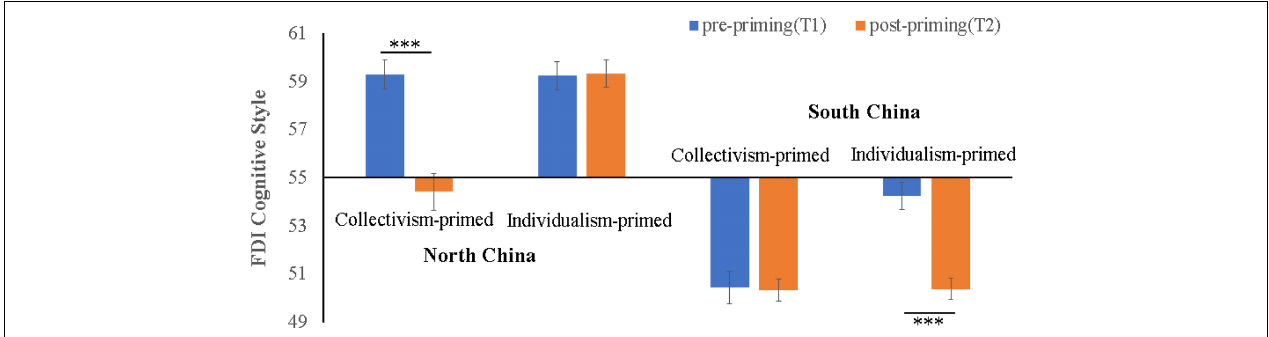
FIGURE 1 | Effect of culture priming on standard EFT scores (T1 and T2). *** p <